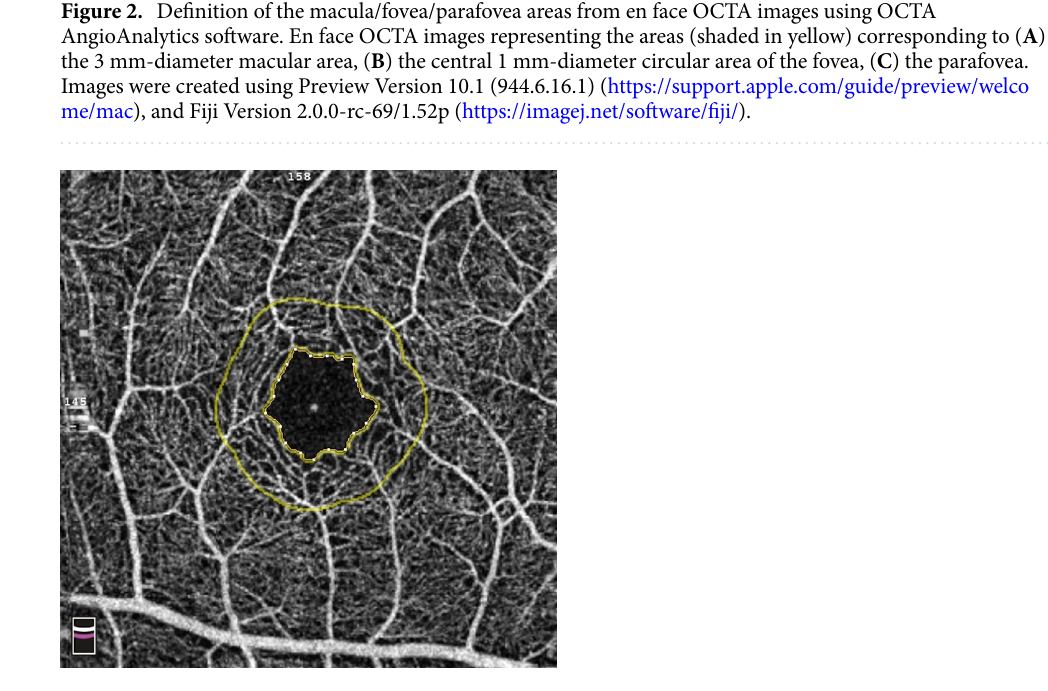
Figure 3. Definition of the foveal avascular zone (FAZ). Optical coherence tomography angiography map showing the contour of the FAZ (inner yellow ring), and a 300 μm wide area surrounding the FAZ (FD-300) (outer yellow ring). Images were created using Preview Version 10.1 (944.6.16.1) (https:// suppo rt. apple. com/ guide/ previ ew/ welco me/ mac).